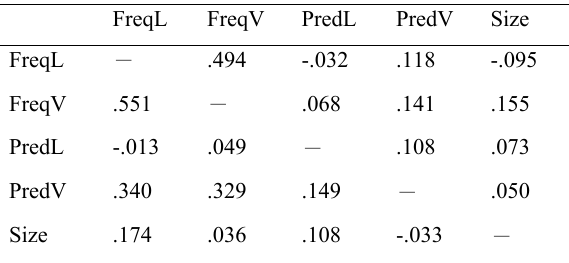
Correlation among predictors for small vs. large objects